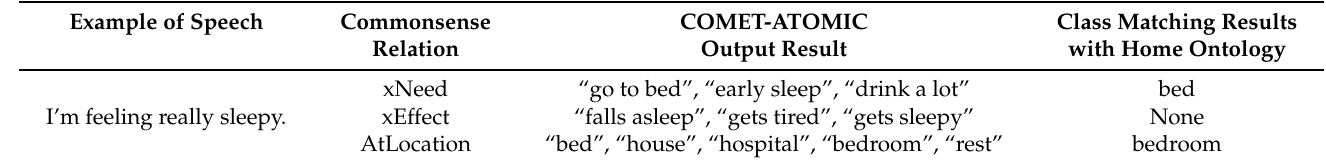
Table 6. COMET-ATOMIC input/output results and class matching results for the correct exam- ple speech.